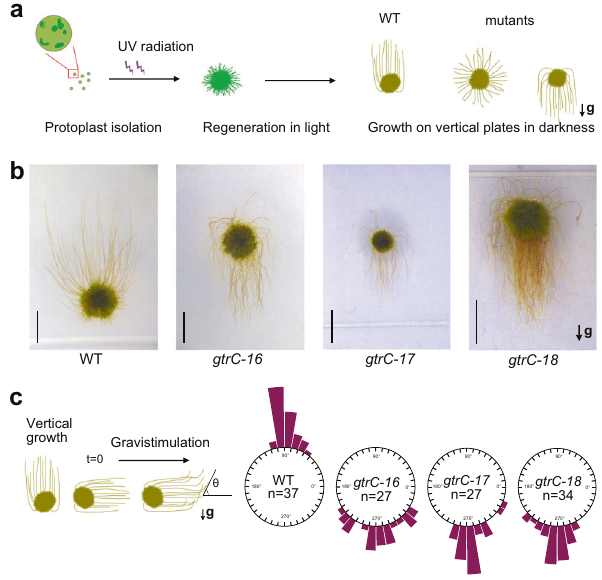
Fig. 1 A group of mutants showing reversed gravitropic responses in Physcomitrella patens . a Schematic diagram of the screening protocol for identifying gravitropic mutants in P. patens . Protoplasts of P. patens were isolated and treated with UV. Next, protonemata were regenerated in light and then grown on vertically oriented culture plates in the dark to record phenotypes. b Gravitropic phenotype of P. patens protonemata. Wild-type Gransden (Gd) strains of P. patens and UV-derived mutants were grown for around 3 weeks vertically in the dark. Scale bars, 3 mm. c Quanti fi cation of bending angles of protonemata growing in the dark for 3 weeks and then gravistimulated for 2 weeks. The schematic diagram shows how the angles were measured, and the bending angles are shown in circular histograms. Source data are provided as a Source Data fi le. In ( a – c ), arrows labeled with “ g ” indicate the directions of gravity